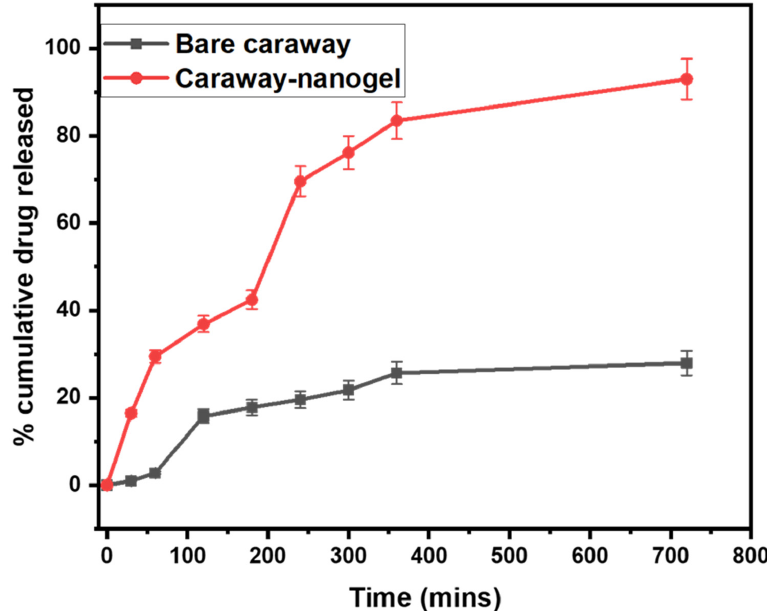
Figure 2. % Cumulative in vitro drug released study of bare caraway essential oil and caraway nanogel in pH 6.8 PBS. Table 1. Kinetic model for bare caraway essential oil and caraway nanogel after dissolution study. Formulation